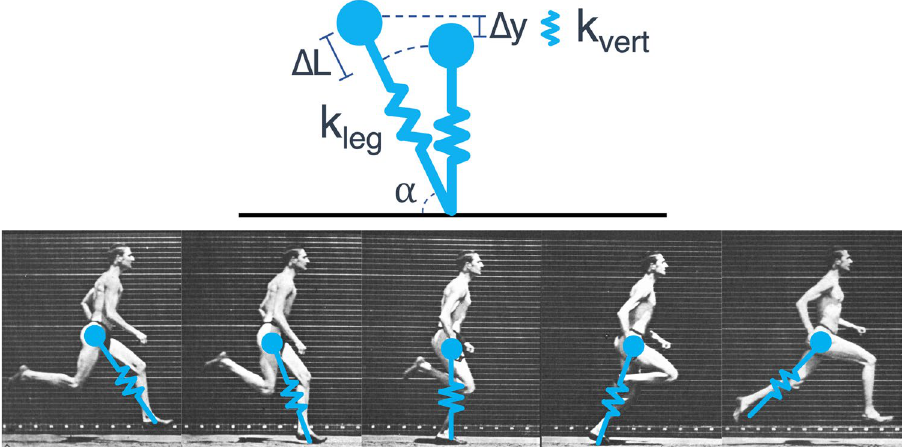
Figure 1. The spring-mass model of running (frames adapted from E. Muybridge 66